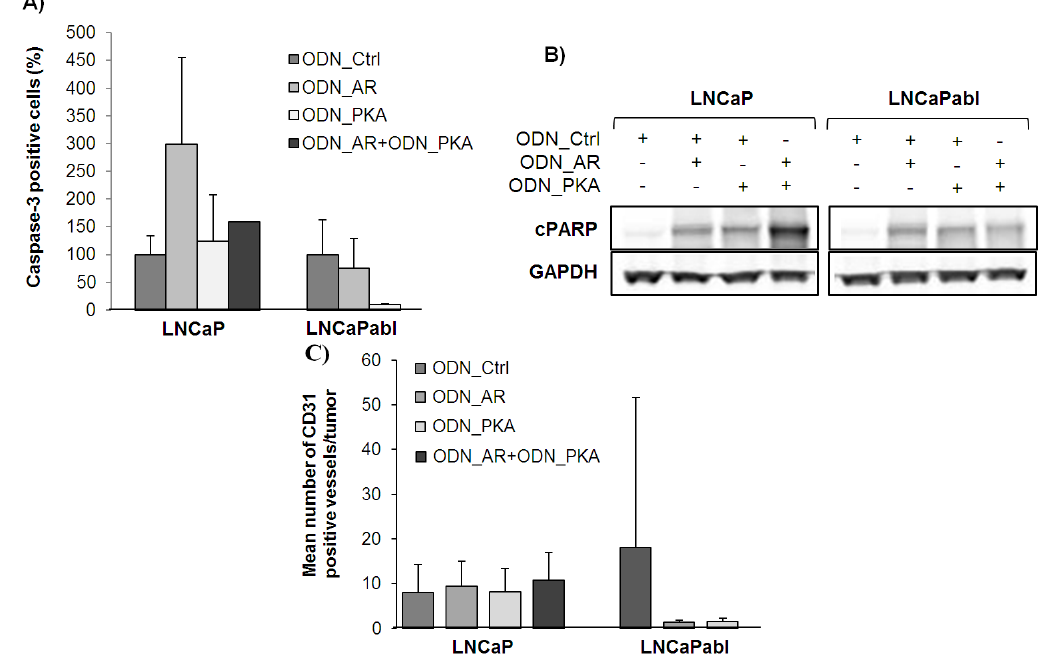
Figure 6. Effects of single or combined treatment with ODN_AR and ODN_PKA on apoptosis and angiogenesis. Athymic nude mice bearing LNCaP and LNCaPabl tumors, respectively, were treated with ODN_AR and ODN_PKA, either alone or in combination, over four weeks. At day 28 of treatment, animals were sacrificed, tumors excised and fixed in formalin and further embedded in paraffin. ( A ) The number of caspase-3 positive cells per tumor was assessed by immunohistochemical staining for cleaved caspase-3 after four weeks of treatment. A tissue microarray was established from LNCaP tumor samples as described under Material and Methods. The number of caspase-3 positive cells was evaluated automatically by using TissueQuest software. In LNCaPabl tumors, the number of caspase-3 positive cells was counted manually; ( B ) Western analysis of lysed LNCaP and LNCaPabl tumor samples, which were harvested after one week of treatment. Immunoblot was performed with an antibody recognizing cPARP p85 fragment. GAPDH was used as loading control; ( C ) Blood vessel count was determined by immunohistochemical staining for CD31 in LNCaP and LNCaPabl tumors harvested after four weeks of treatment. The number of CD31 positive vessels was counted manually and displayed as the mean number of vessels normalized with tumor size ±